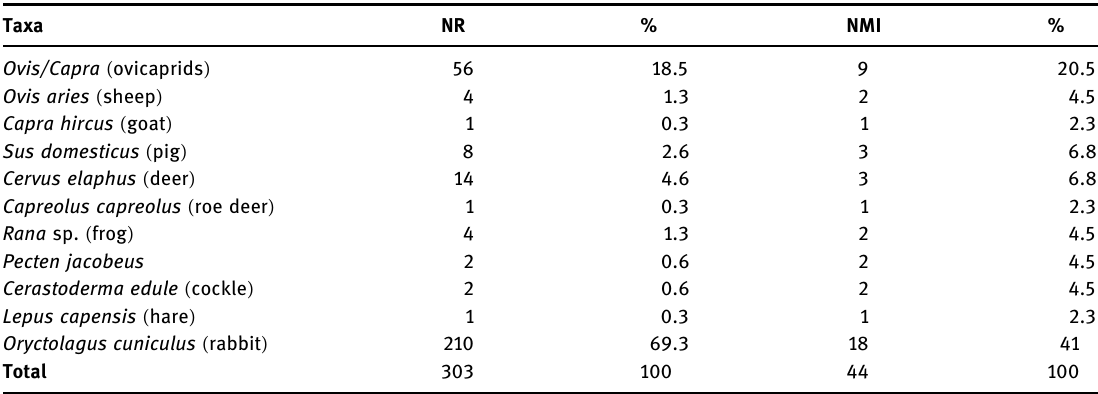
Table 2: Number of remains ( NR ) , minimum number of individuals ( MNI ) , and percentages of the fauna found in the hearth of the EH